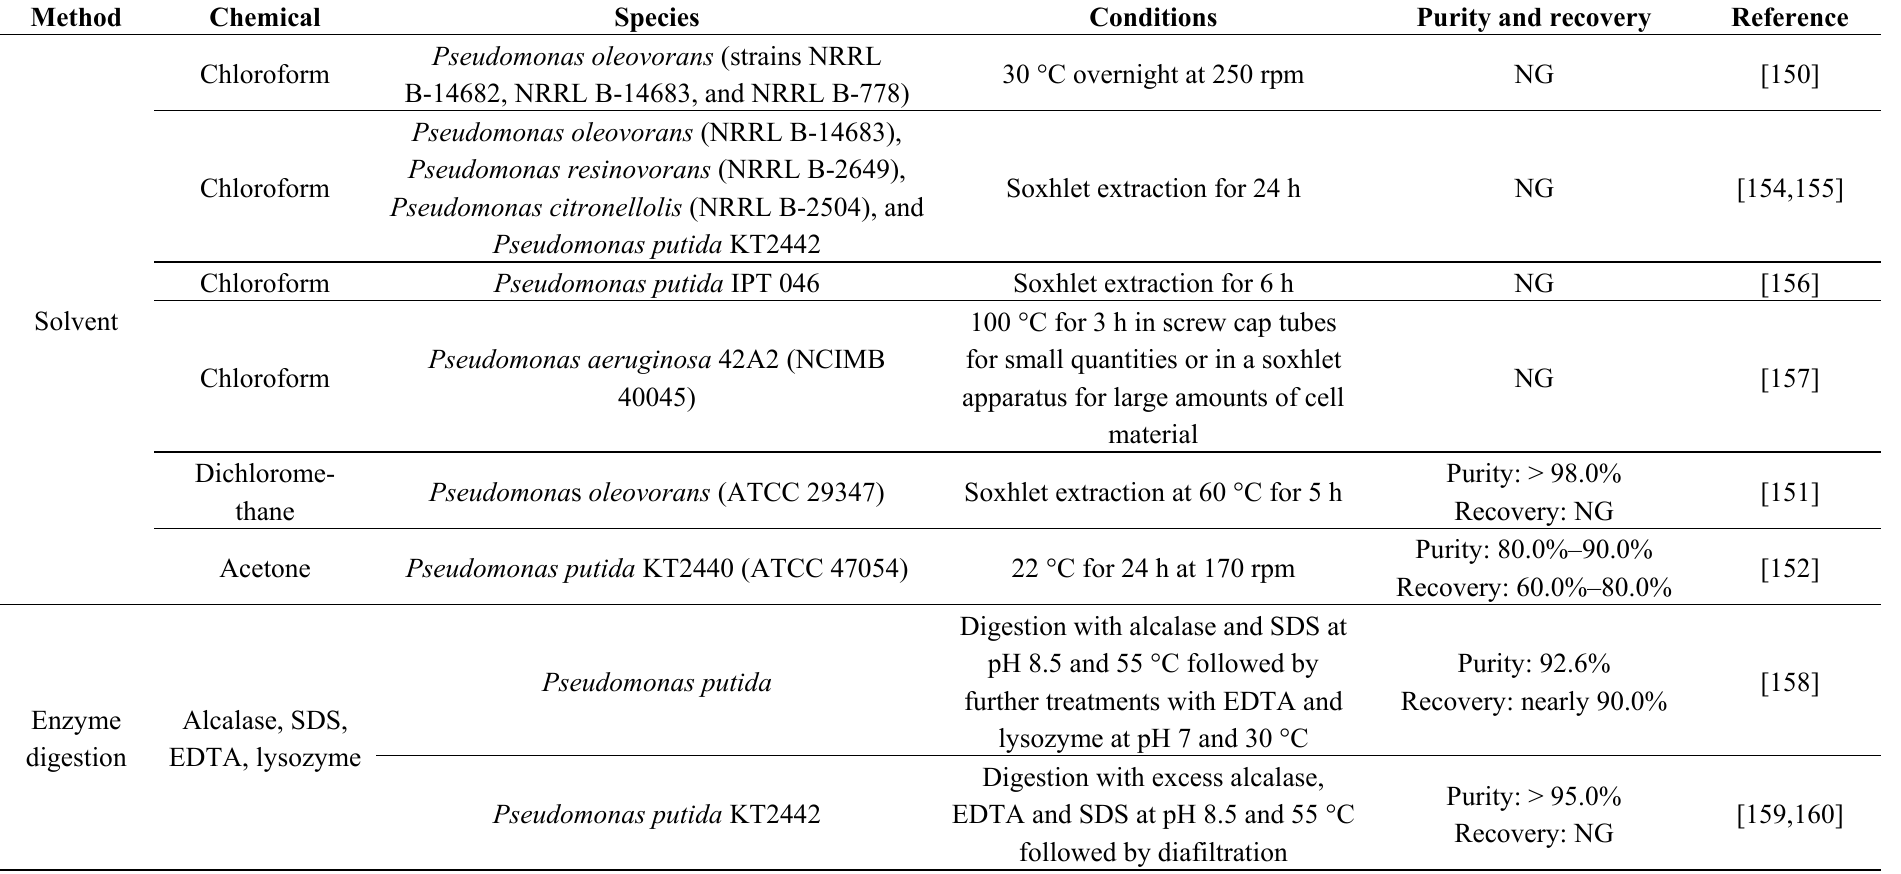
Table 5. Medium-chain length PHA (mcl-PHA) recovery